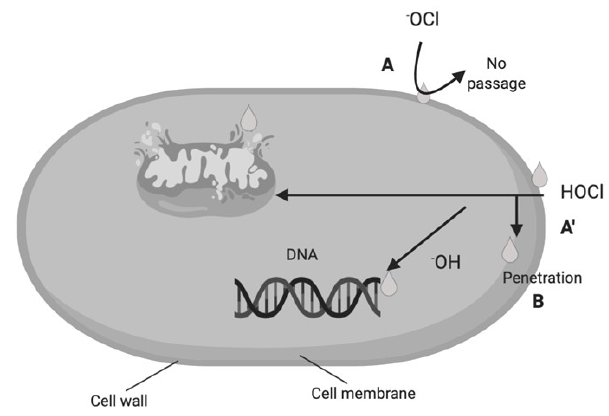
Figure 2. EW bactericidal activity. The hypochlorite ion ( − OCl) cannot penetrate bacterial membrane A. Hypochlorous acid (HOCl) can diffuse through bacterial membrane and disrupt outer membrane A’, internal membrane B, and bacterial proteins C. Alteration of bacterial DNA has been reported (Adapted from Rahman [20]).